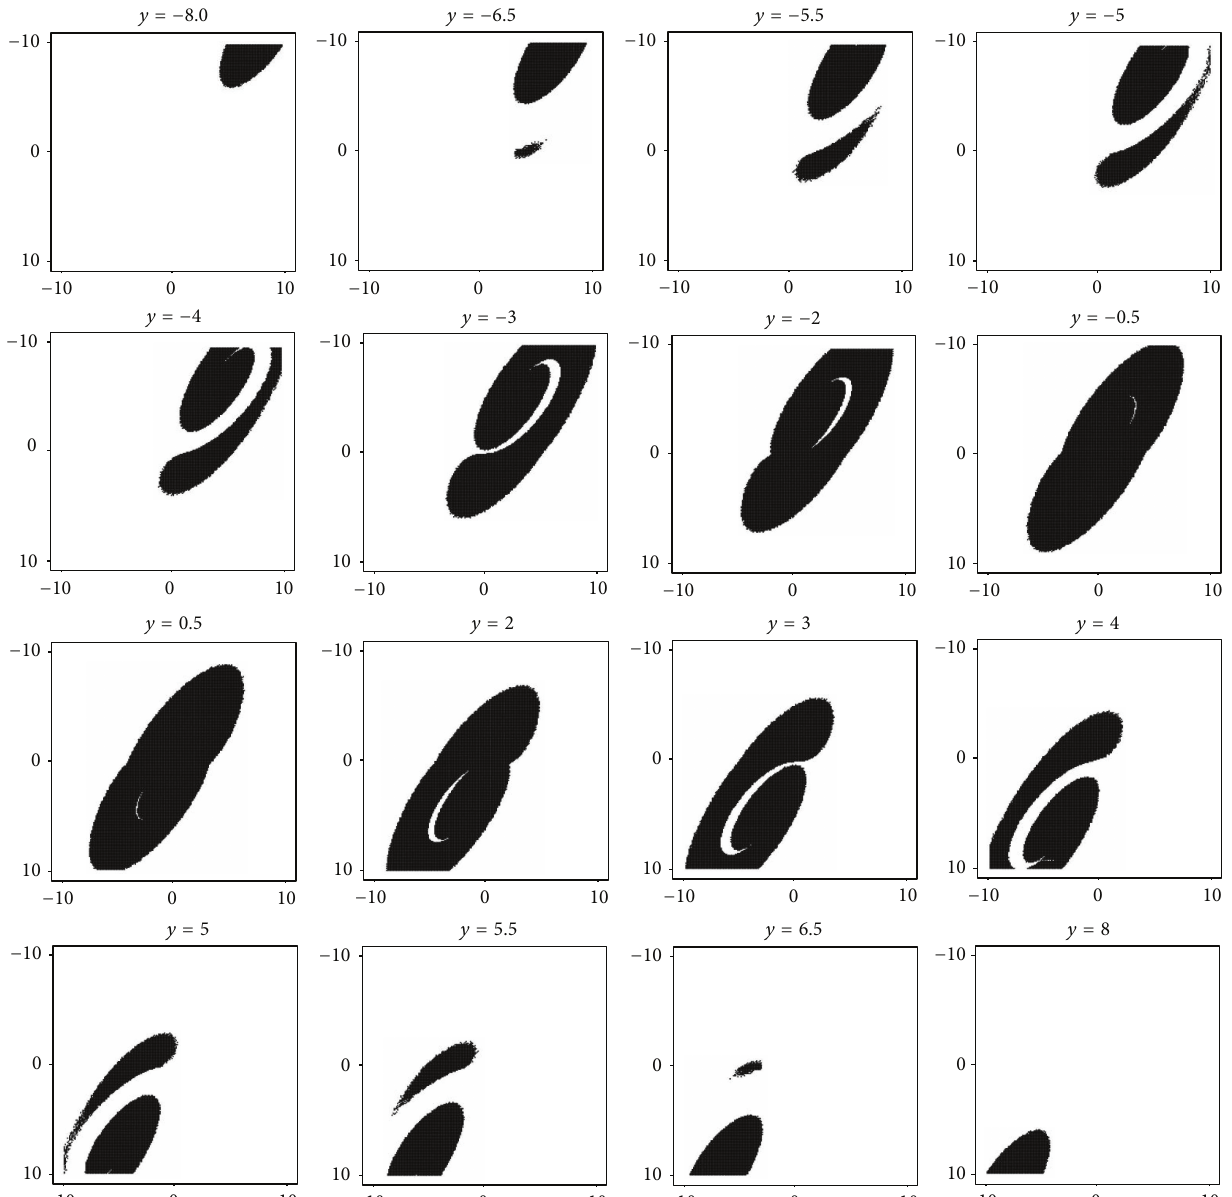
Figure 7: The graphical illustration of the basin of attraction for chaotic attractor, system case 𝐴 . These slices are 𝑥 - 𝑧 projections of cross- sections with the 𝑦 -axis. Black region represents initial condition inside basin of attraction. All other trajectories tend to